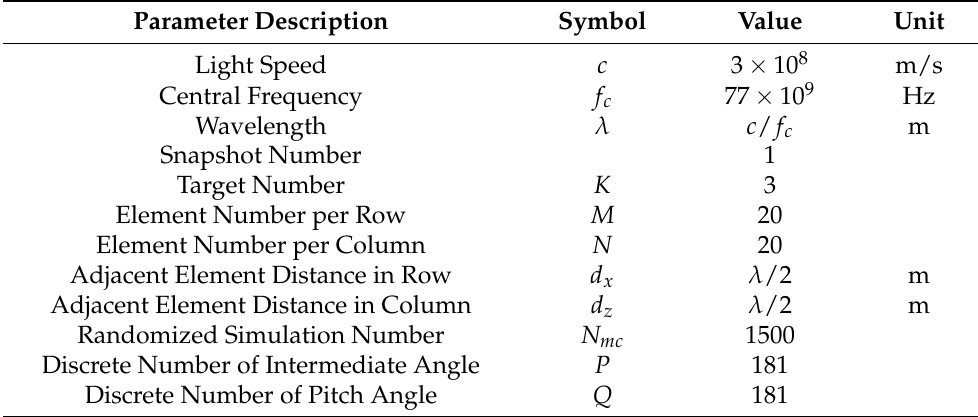
Figure 3. Average RMSE of the estimated angles of three targets in 1500-trials Monte Carlo simulations. Table 1. Main simulation parameters.